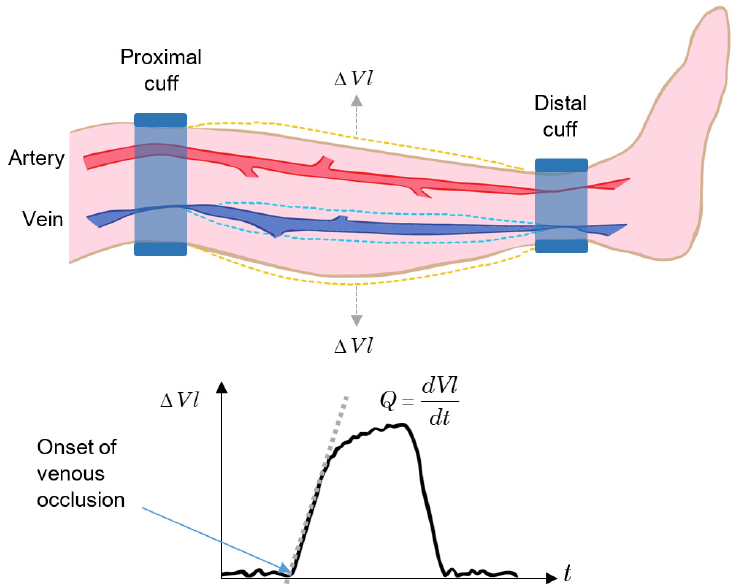
Figure 6. Schematic of the venous occlusion plethysmography method based on [80].